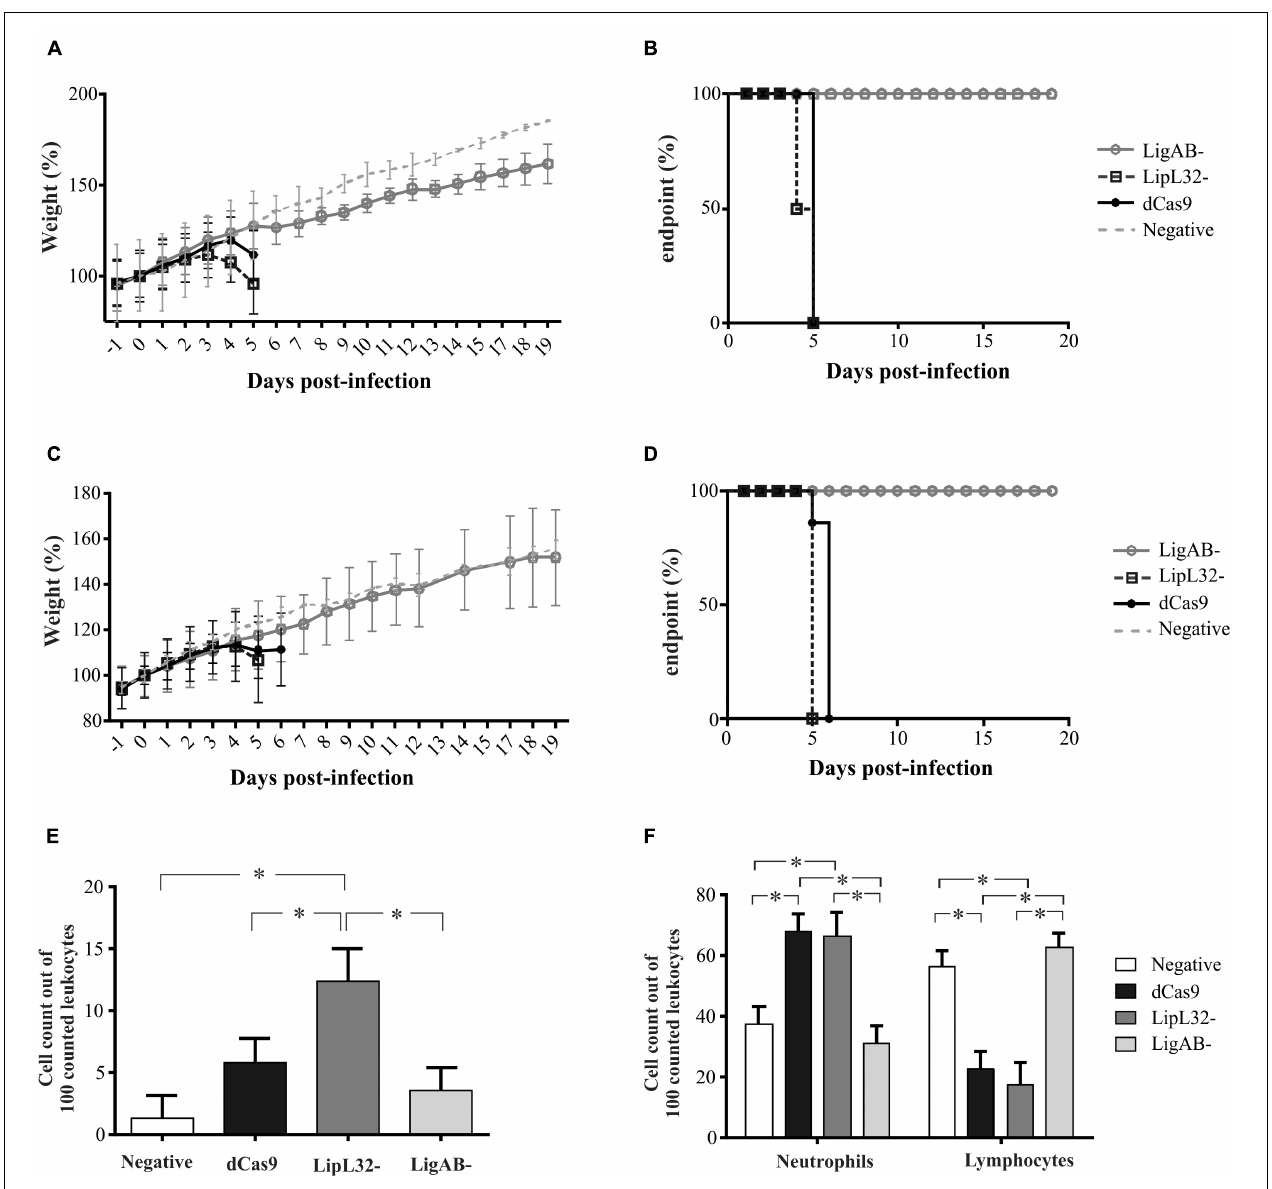
FIGURE 4 | Weight loss, end-point curves, and blood cell counts from infected animals. Hamsters ( n = 4) were injected intraperitoneally with L. interrogans cells (10 8 ) containing empty pMaOri.dCas9 plasmid (dCas), mutants for LipL32 or LigAB or media alone (negative control). Animals were monitored daily for weight (A,C) and clinical signs of acute leptospirosis, the appearance of which defined endpoints (B,D) . Graphics in panels (A,B) refer to the first experiment, and in panels (C,D) to the second. Panel (E) denotes the presence and counts of circulating foamy macrophages, and (F) denotes neutrophil and lymphocyte counts among challenge groups. ( ∗ ) denotes p -values ≤ 0.05. Least squares means and standard errors are